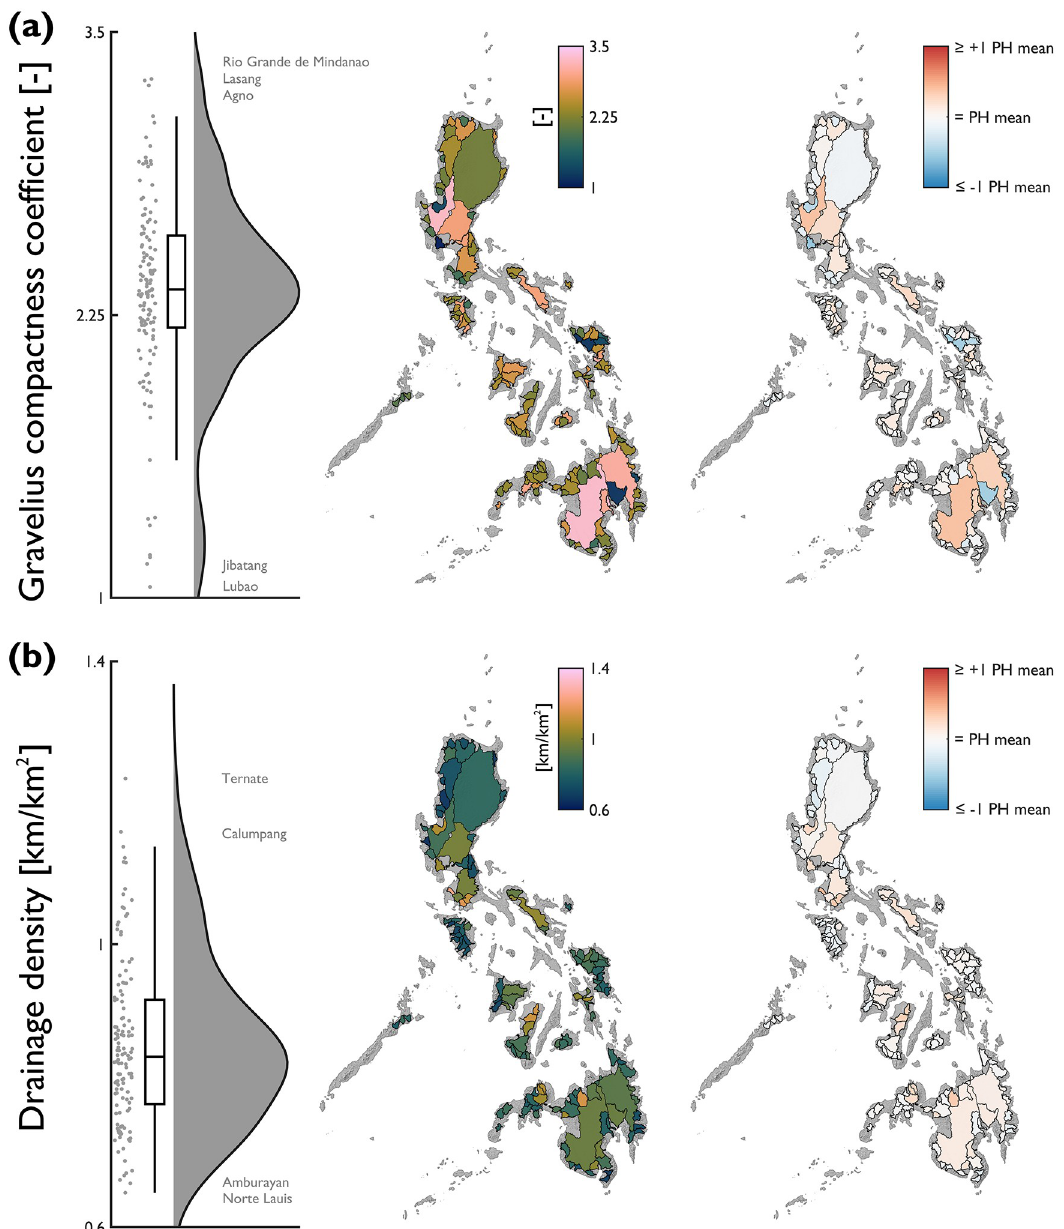
Fig 4. National-scale assessment of catchment shape and drainage characteristics expressed by: (a) Gravelius compactness coefficient; and, (b) drainage density. Note that for the red-blue choropleth map, values are displayed relative to the Philippine average for each attribute (Gravelius compactness coefficient = 2.36; drainage density = 0.86 km/km 2 ). Annotations on the raincloud plots denote catchments with notably high/low